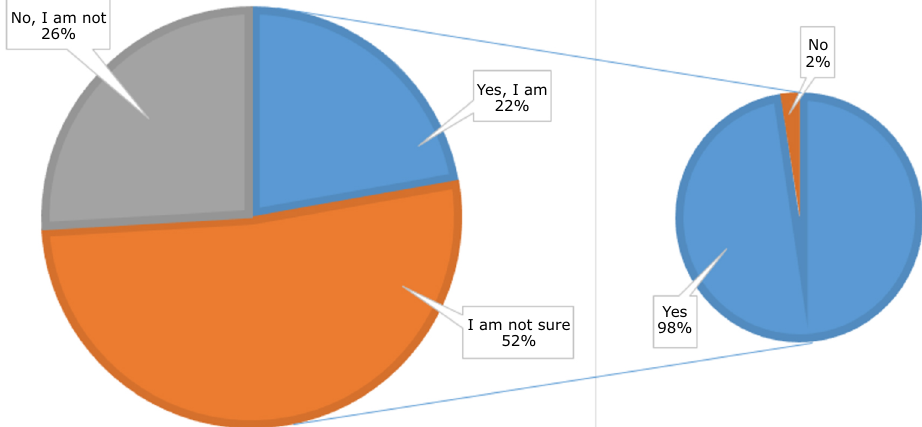
Fig. 2. Familiarity with the concept of system archetypes